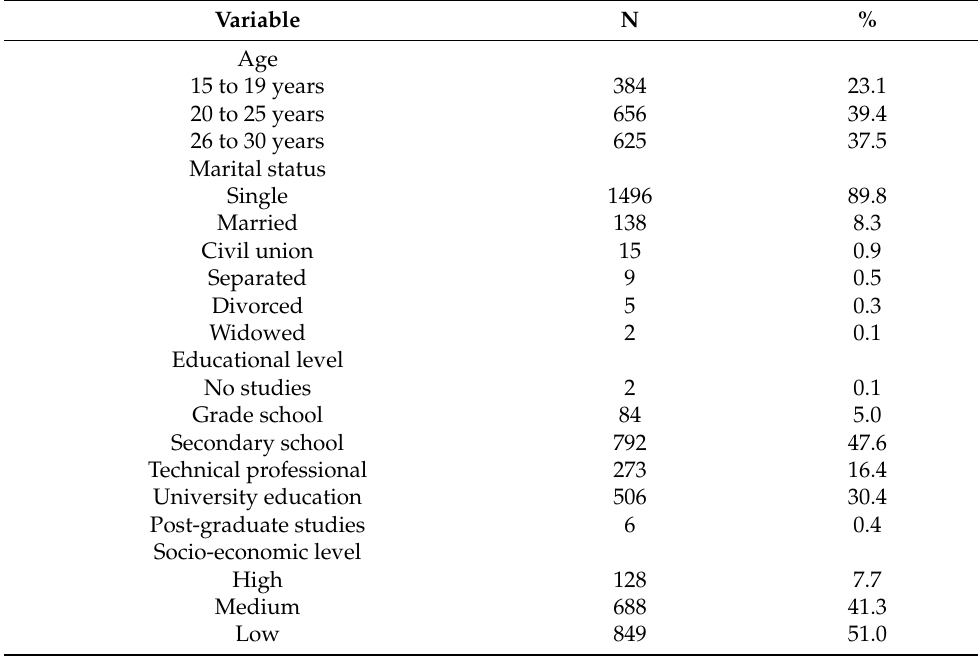
Table 1. Sociodemographic variables of the